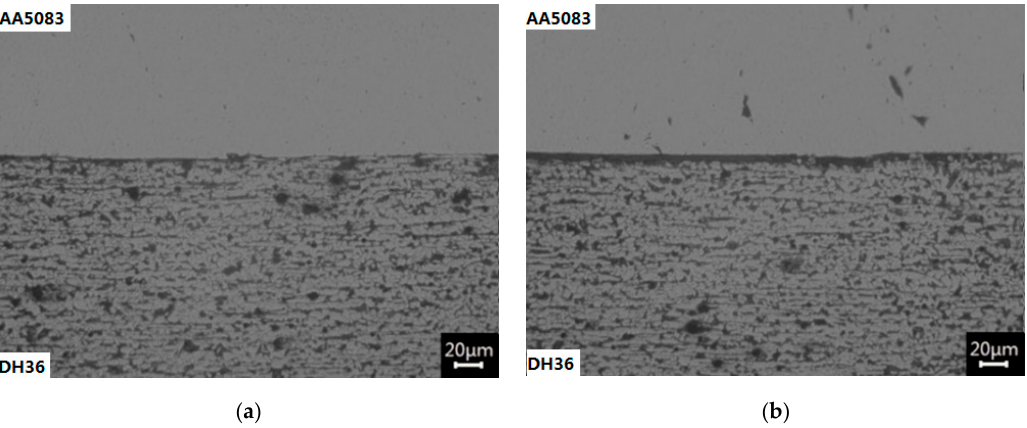
Figure 14. Deposition microstructures for specimen No. 9: ( a ) middle ( b ) retreating side.